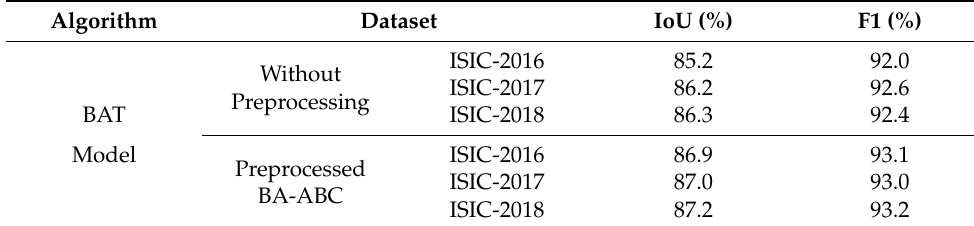
Table 4. Performance matrix comparison with BAT